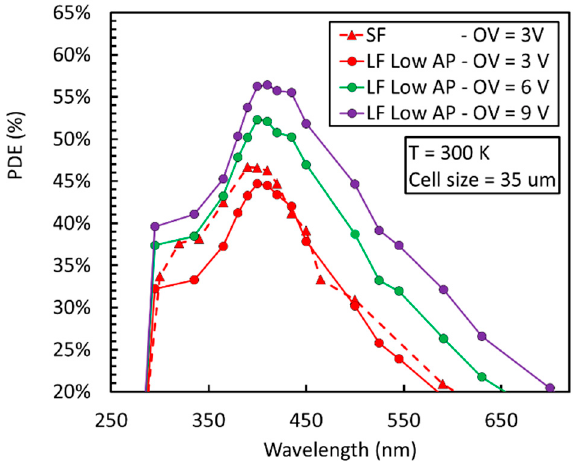
Figure 22. PDE measured at 293 K on 35 µ m cell, NUV-HD–Cryo SiPM, compared to that of a standard NUV-HD SiPM, with the same cell size.